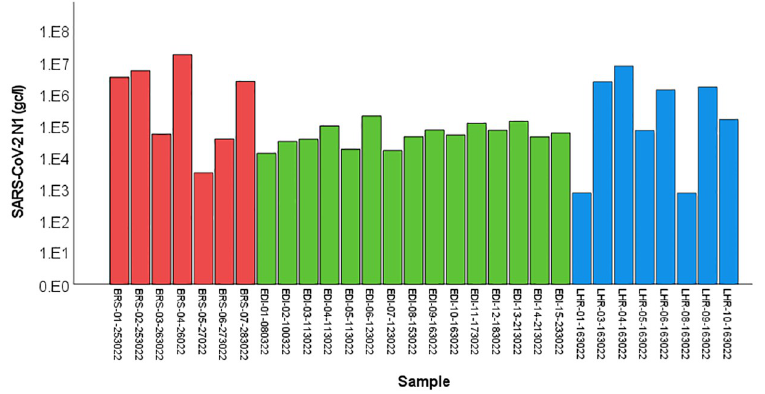
Fig 4. SARS-CoV-2 RNA concentration in samples taken from vacuum trucks at Bristol (BRS–red bars), at Edinburgh (EDI–green bars) and at Heathrow (LHR–blue bars) airports.